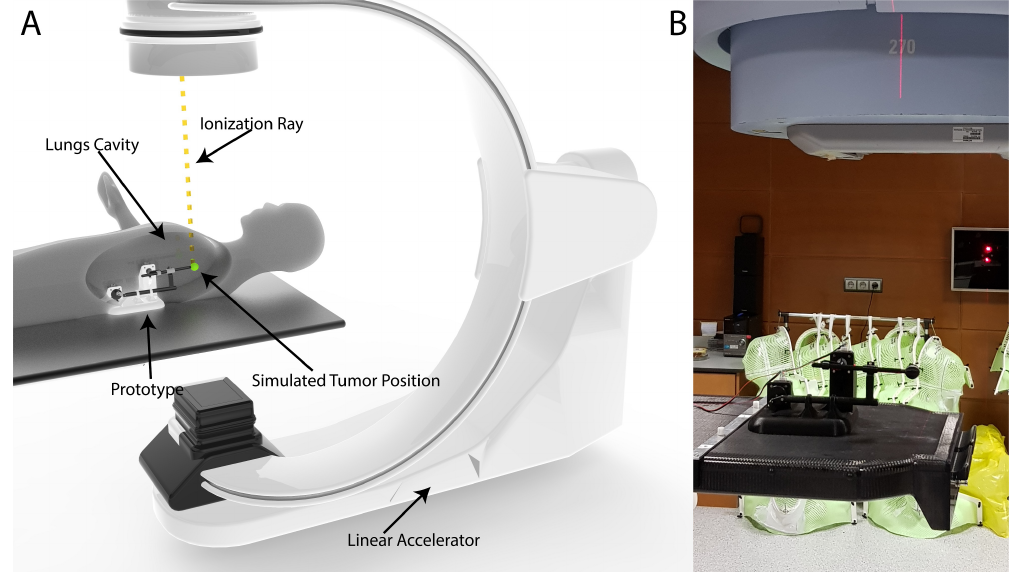
Figure 7. ( A ) Virtual reconstruction of the location where the prototype should be placed to simulate the tumor path is shown; and ( B ) the real Lung Tumor Movement Simulator placed inside a